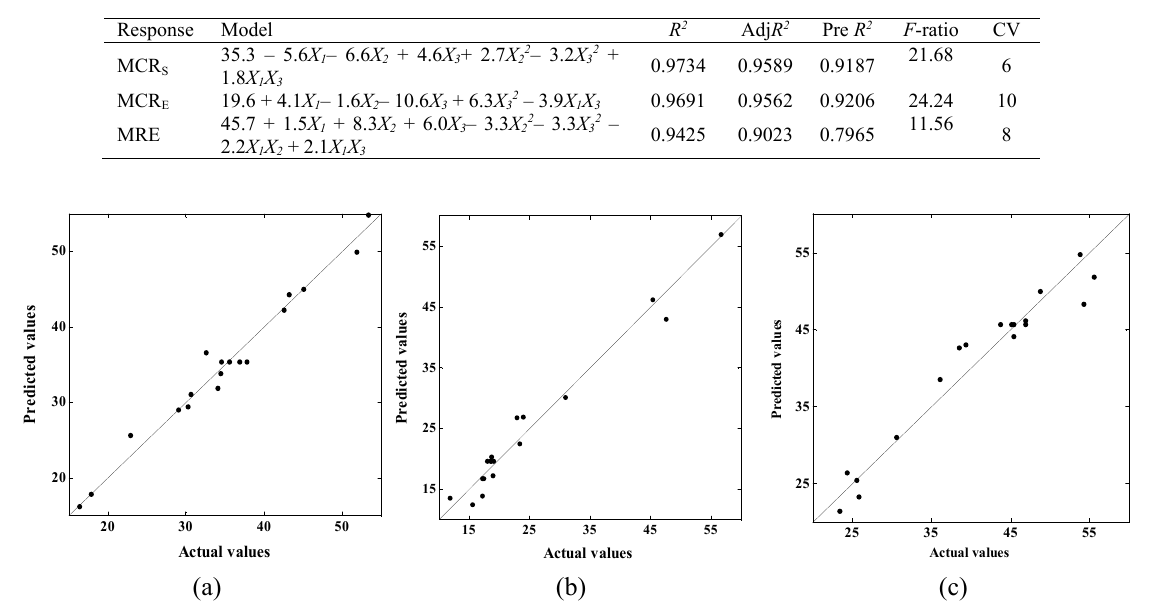
, (b) MCR , (c) MRE. S E